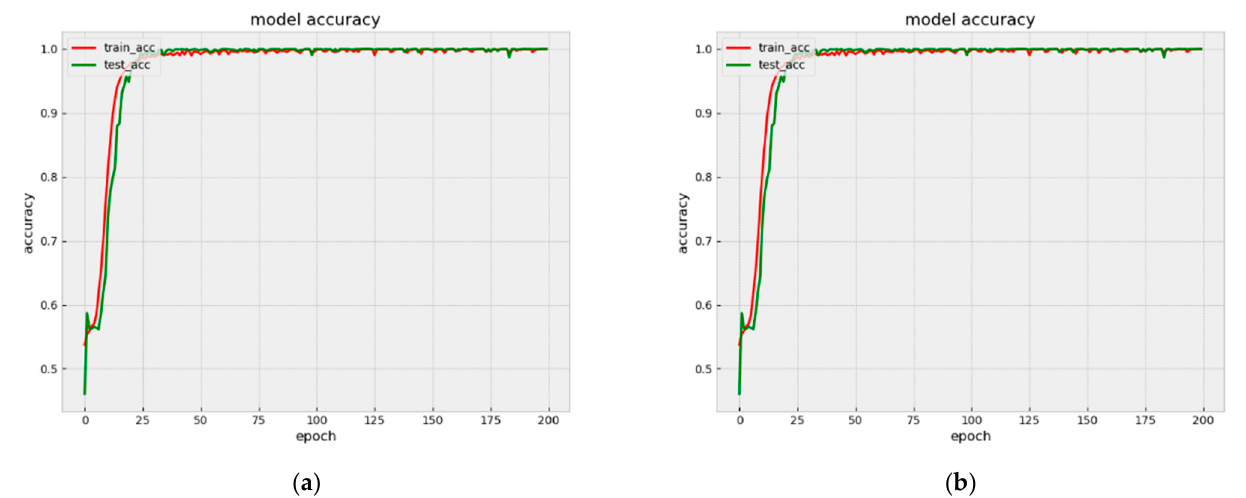
Figure 9. Model accuracy and loss curves ( a ) accuracy in Valence, ( b ) loss in Valence.